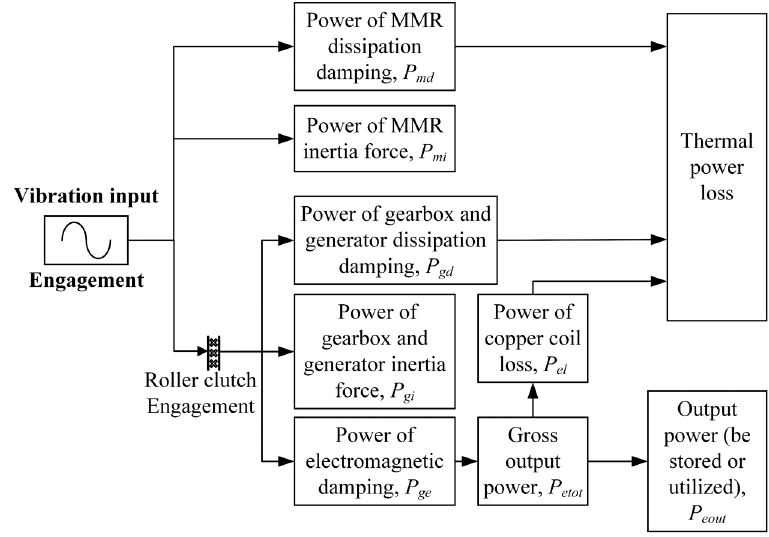
Figure 5. The power flow of the engagement behavior.